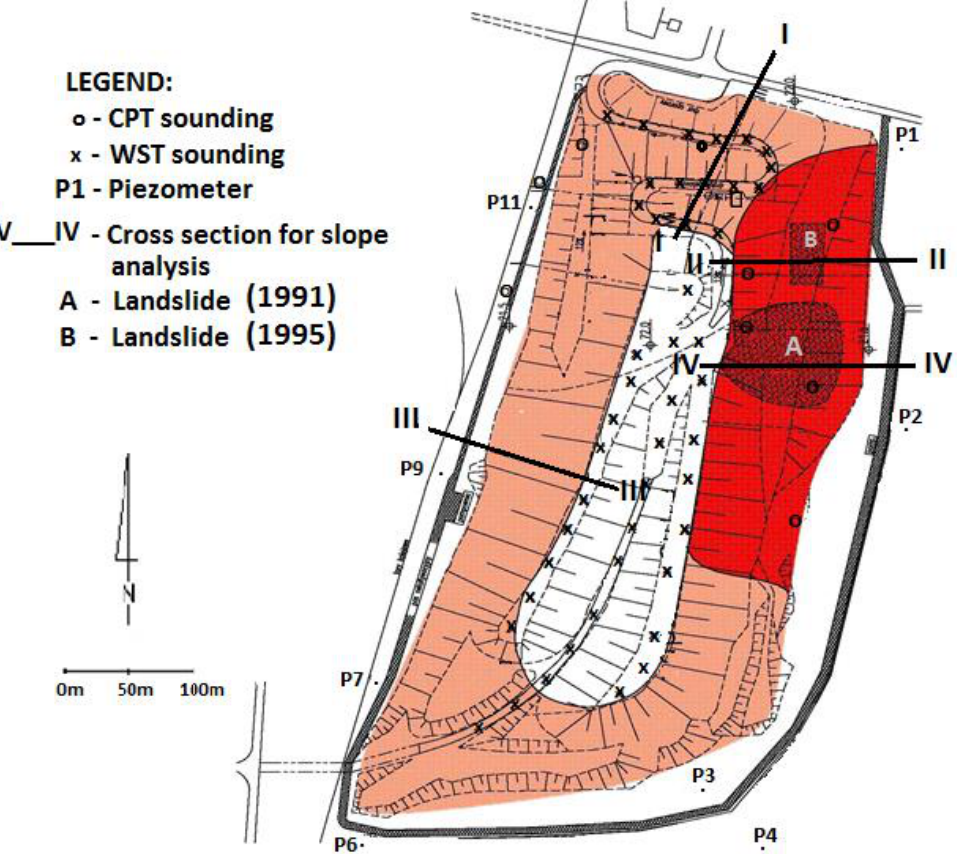
Figure 6. Geotechnical safety assessment based on “traffic lights” approach applying observational method framework—no slope method framework—no slope reinforcements.